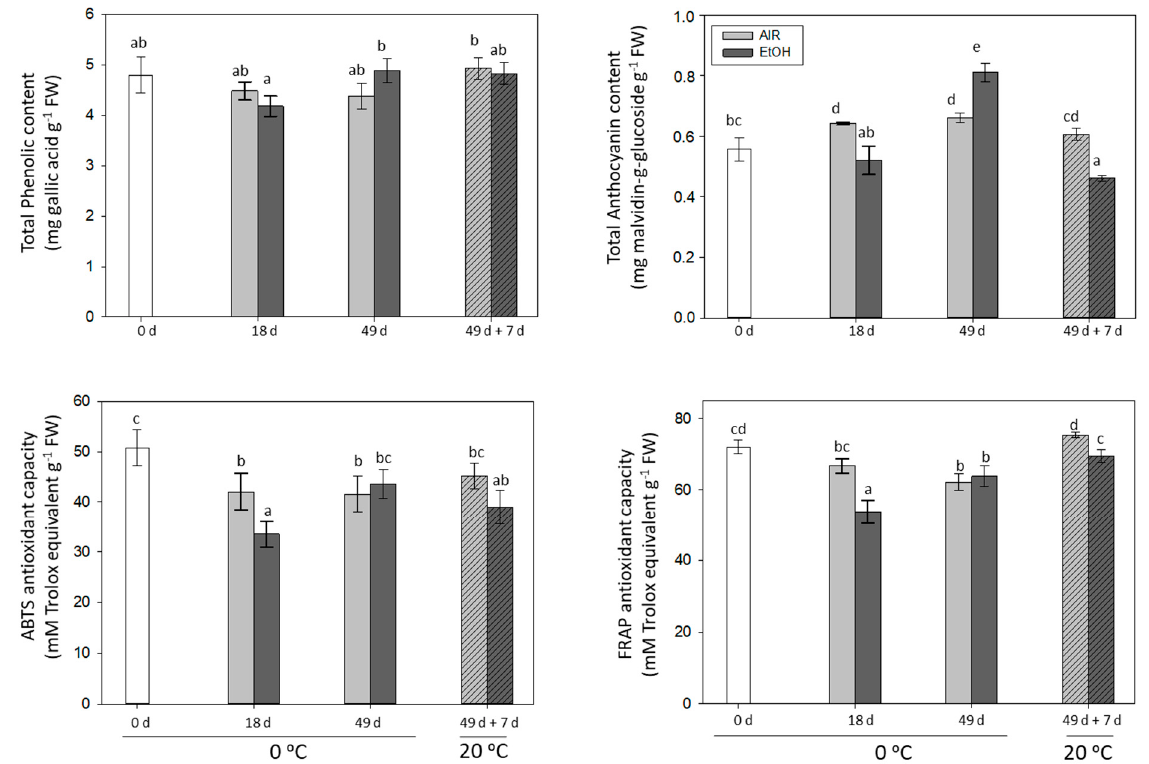
Figure 4. Changes in total phenolic content, anthocyanin content and antioxidant activity, determined by ABTS and FRAP, in the skin of non-treated and ethanol-treated It 681–30 table grapes stored up to 49 days at 0 °C and during the shelf-life period (49 d + 7 d at 20 °C). Values are the mean ± SD, n = 3. Different letters on the bars indicate that the values are statistically different using the Tukey-b test ( p < 0.05).